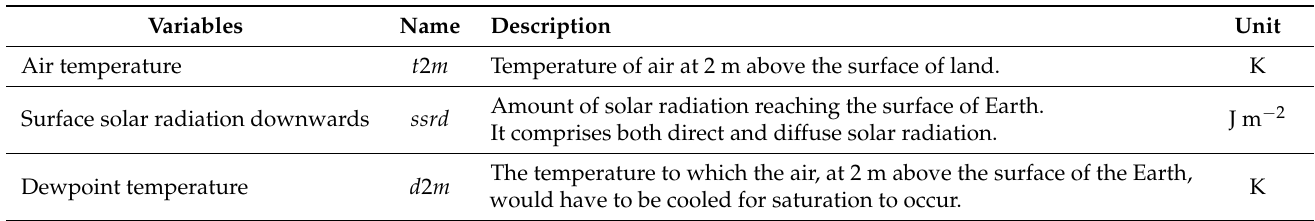
Table 2. ERA5-Land downloaded data description.